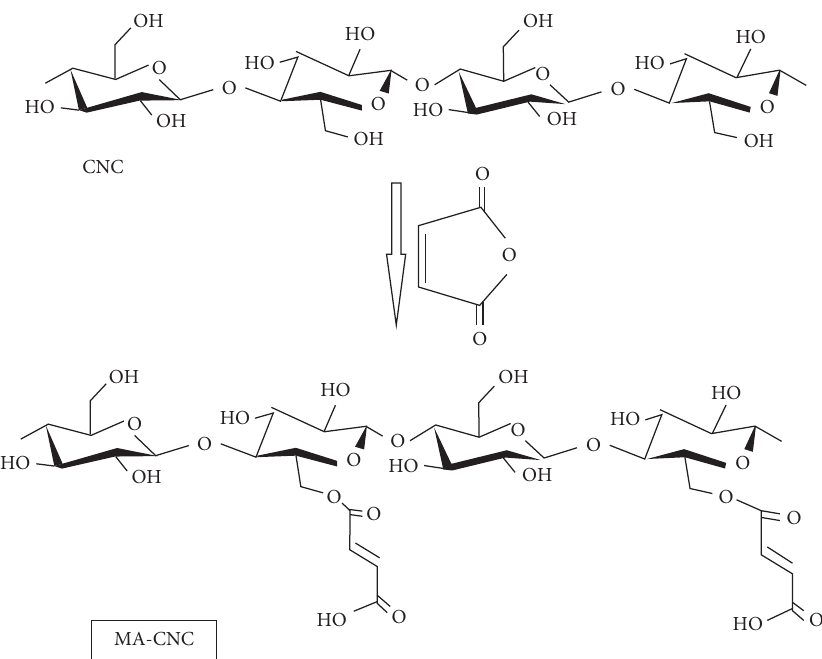
Figure 2: Esterification of cellulose nanocrystalline (CNC) by using maleic anhydride (MA).